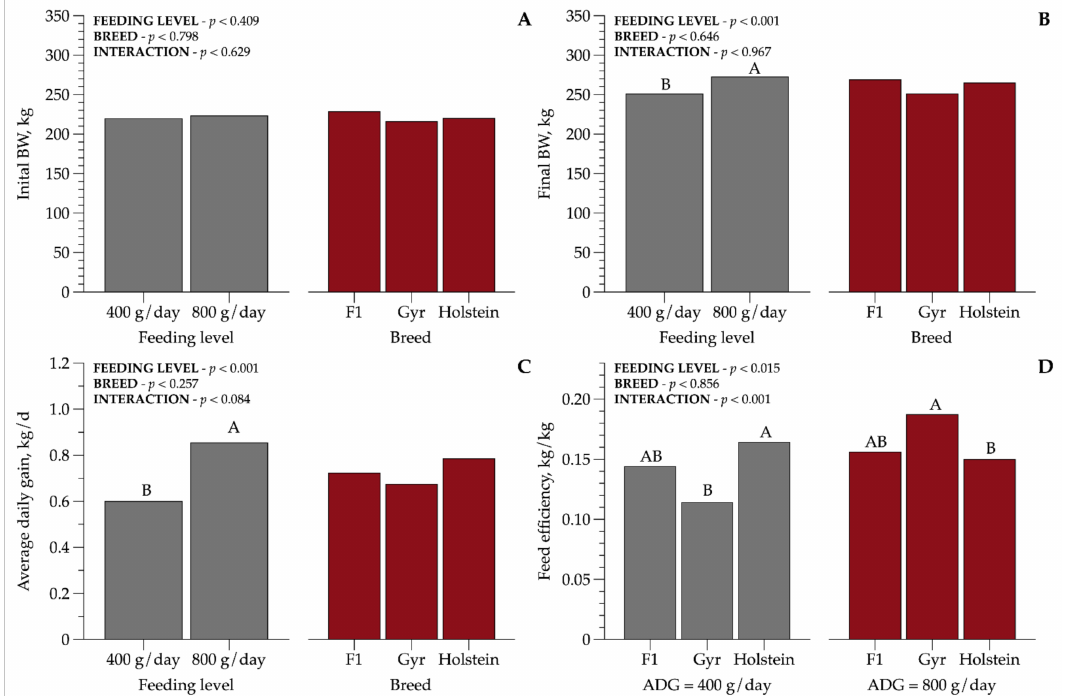
Figure 1. Initial and final body weight (kg): ( A , B ), average daily gain (ADG/kg), and feed efficiency: ( C , D ) of dairy heifers of three breed compositions (BCs) at two feeding levels (FLs). Values that differ significantly ( p < 0.05) are noted with different letters (A, or B). n = 72.